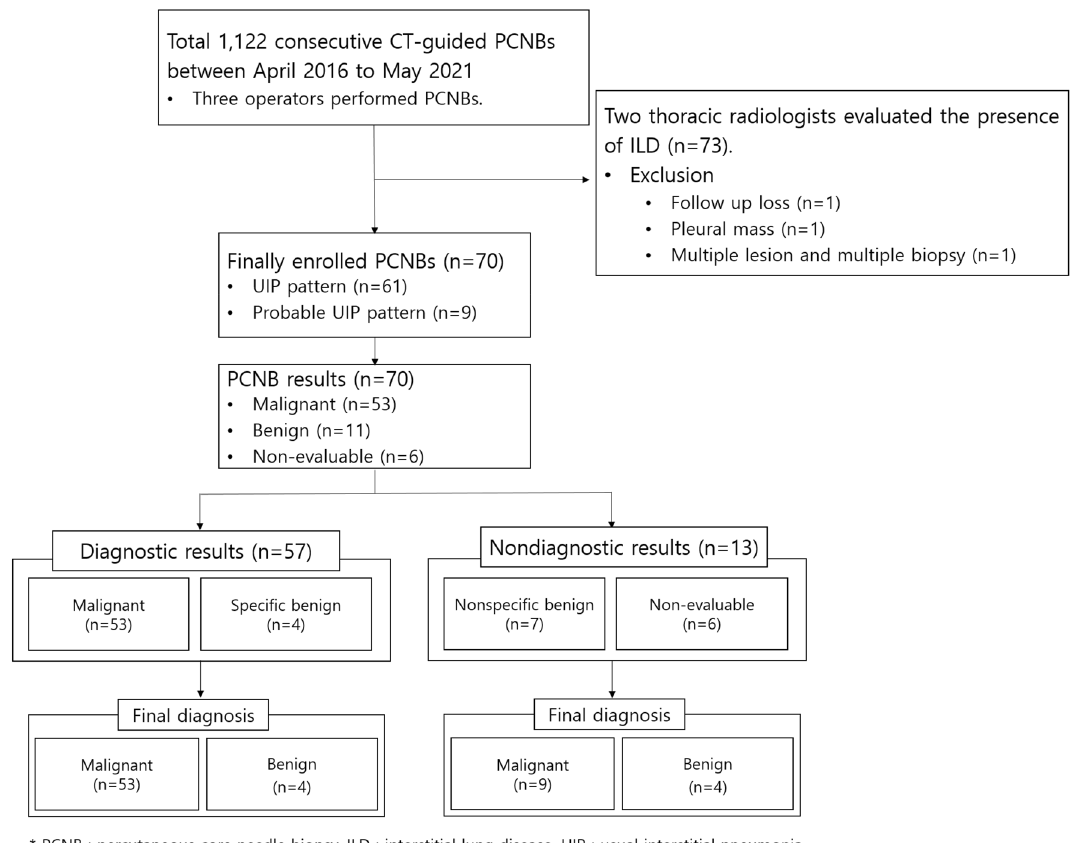
Figure 1. Patient flow diagram and pathology results of percutaneous core needle biopsies (PCNBs) in this